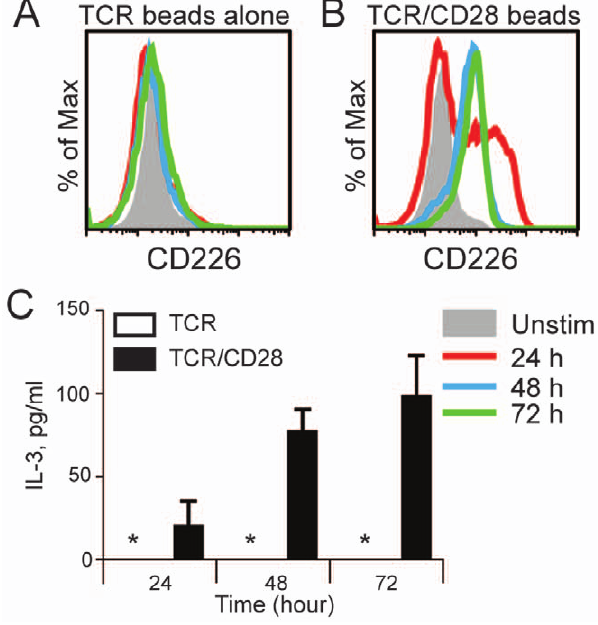
Figure 3. CD28 signaling increases CD226 expression and IL-3 secretion in CD4 T cells. Sorted naı¨ve CD4 + CD25- T cells from C57BL/ 6 wild type mice were stimulated with bead-bound anti-CD3 alone (A) or anti-CD3 plus anti-CD28 (B) for the indicated times. Cells were stained for CD226 surface expression (A, B) and supernatants were used to quantify IL-3 secretion (C). Data were acquired by flow cytometry and analyzed using FlowJo software. Asterisk (*) indicates below detection limit (1.1 pg/mL). These results are representative of at least 3 independent experiments.